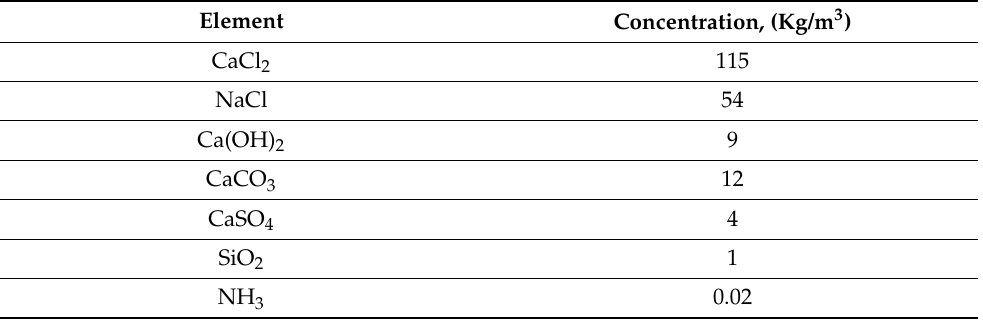
Table 1. Composition of Solvay wastewater.